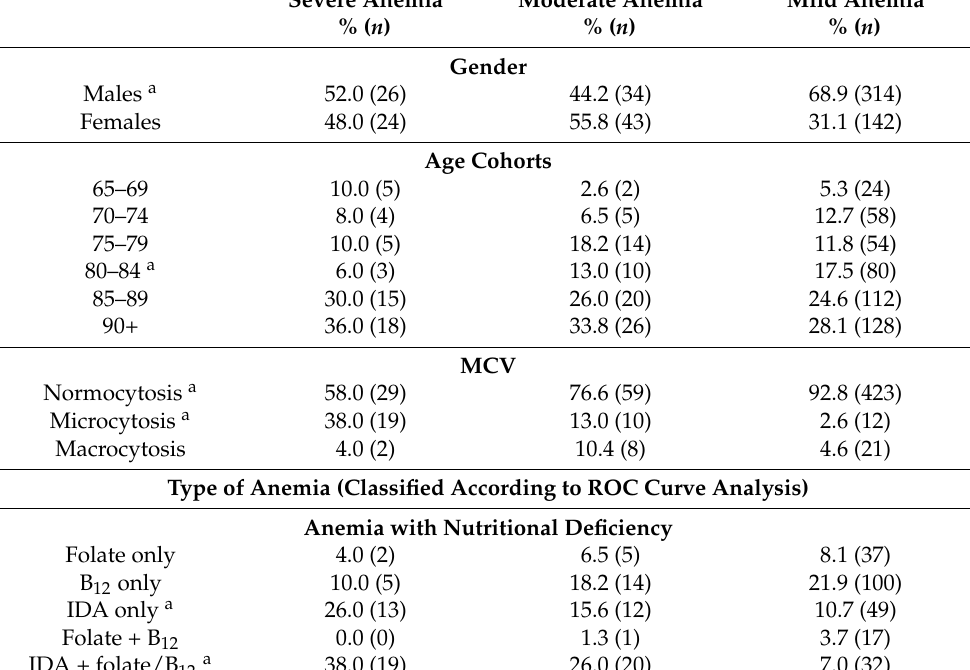
Table 5. Characteristics of severe (hemoglobin [Hb] < 10 g/dL), moderate (Hb: 10–11 g/dL), and mild anemia in different types of anemia in the PolSenior